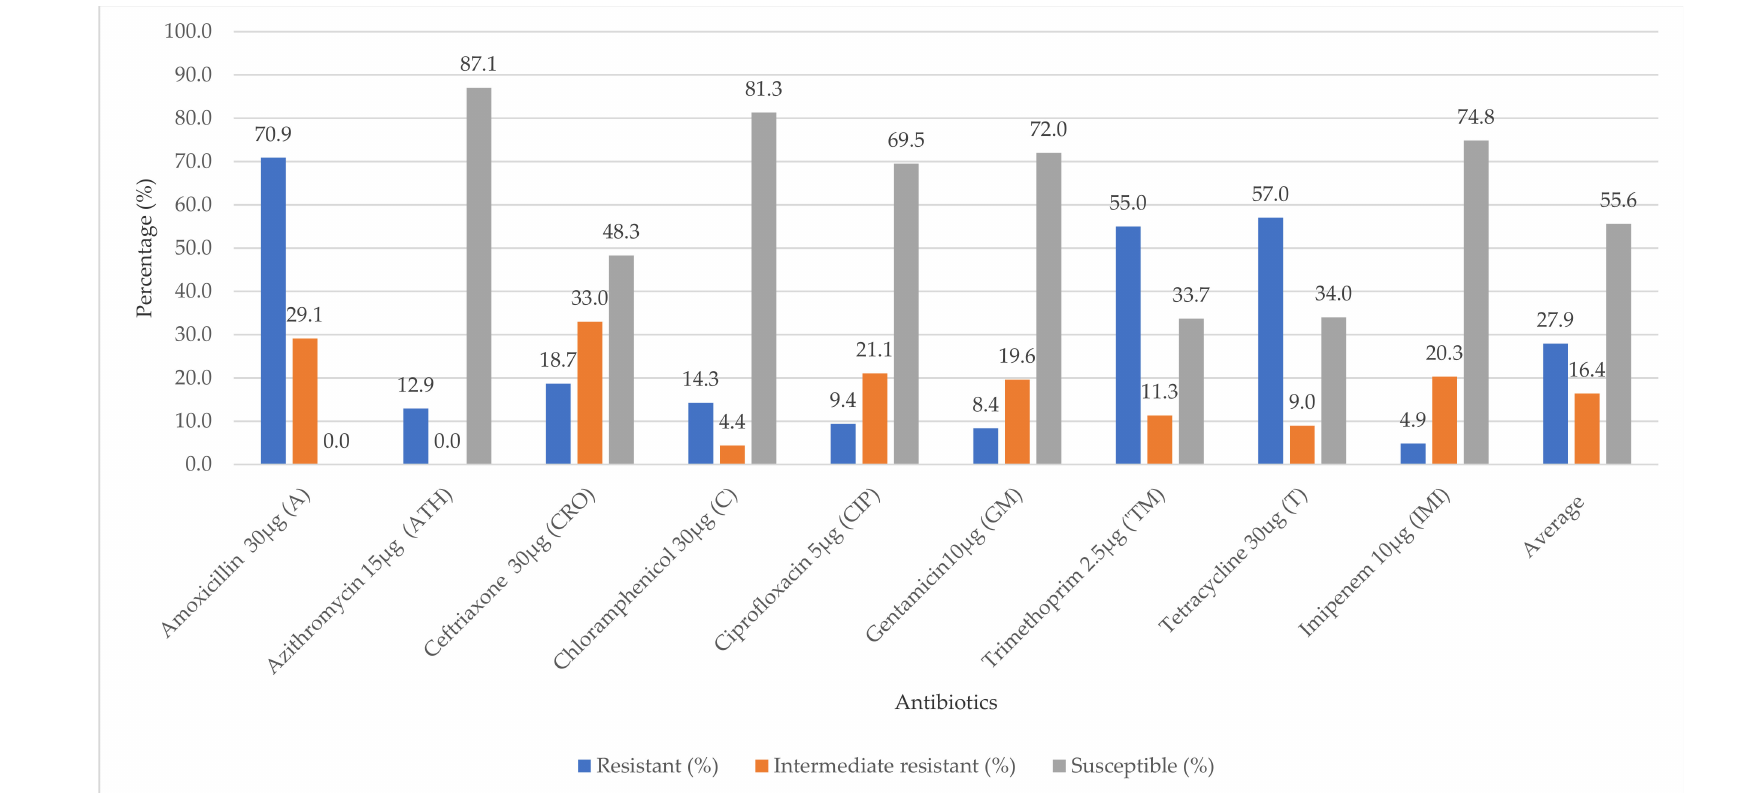
Figure 1. Overall antibiotic susceptibility of E. coli ( n = 45) isolated from raw meats, RTE meats and their related